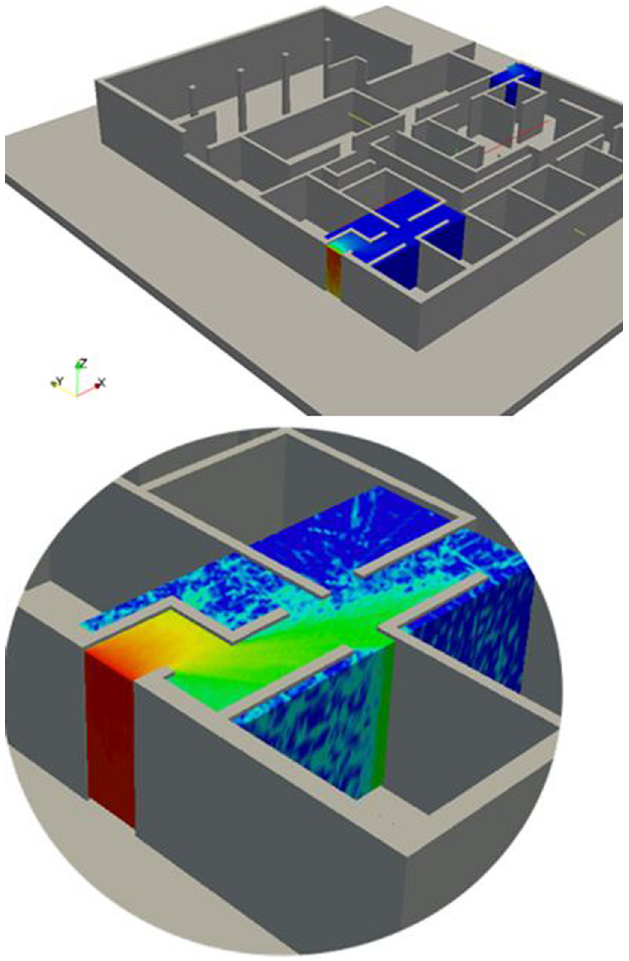
Fig. 5. Emergency exit detail.